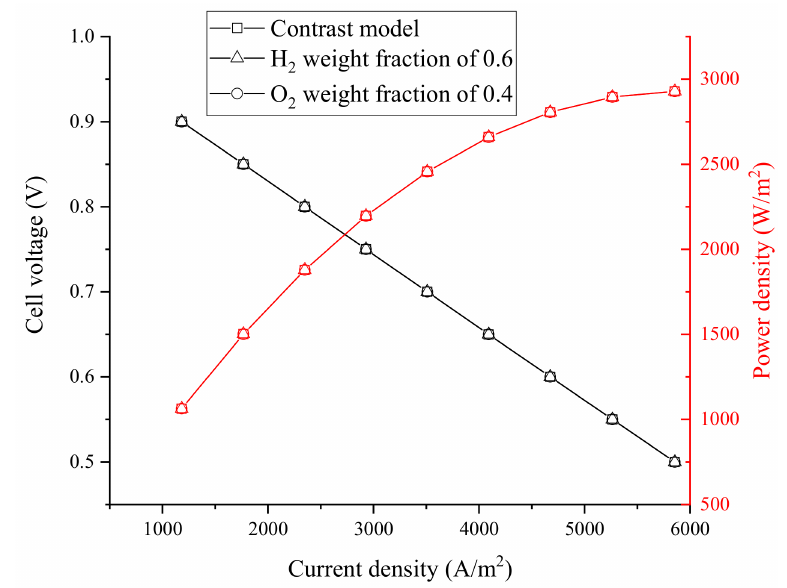
Figure 6. Comparison among the different inlet gas